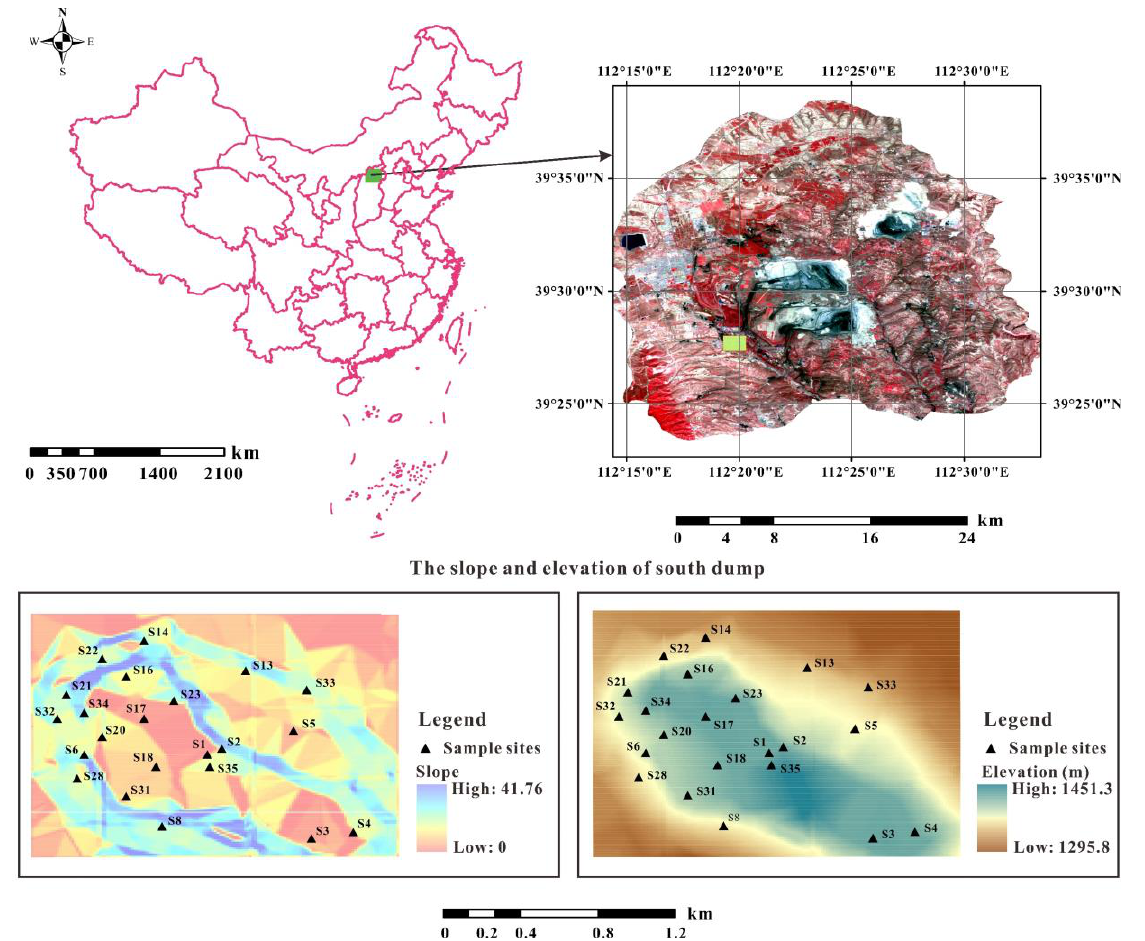
Figure 1. The location, slope, elevation and sample sites of the South Dump in the Pingshuo opencast coalmine, China.